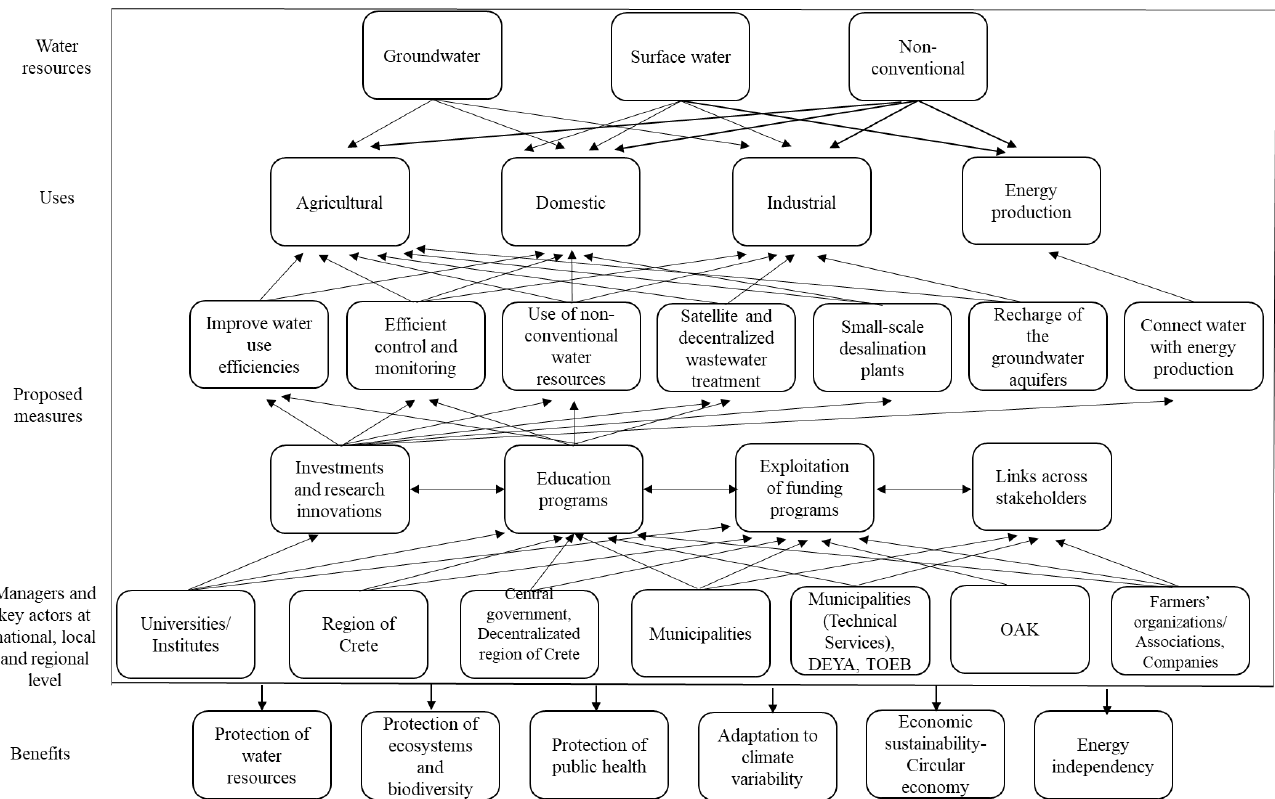
Figure 12. Schematic representation of water uses, proposed measures, and key actors and managers of water management in Crete.